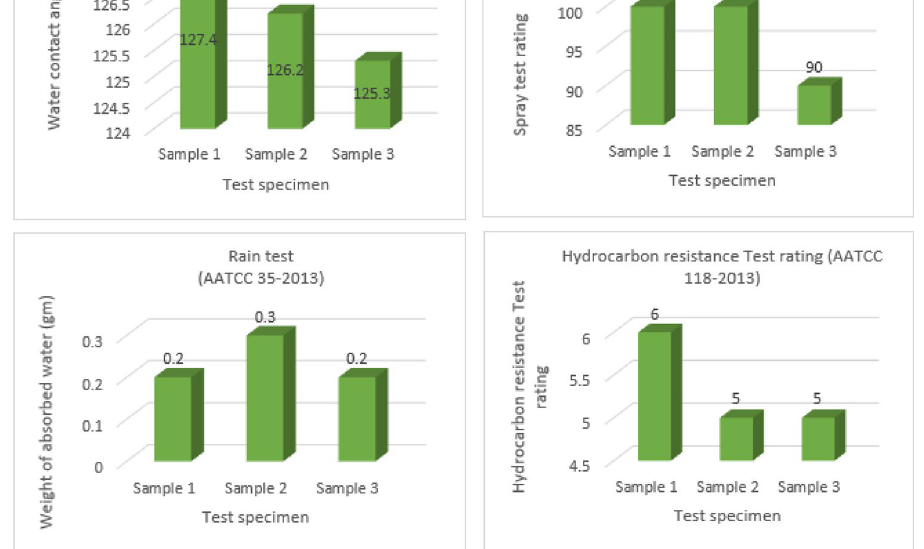
Fig. 21 Microscopic images of the HDTMS-treated nonwoven cotton fabric a before testing, b after testing